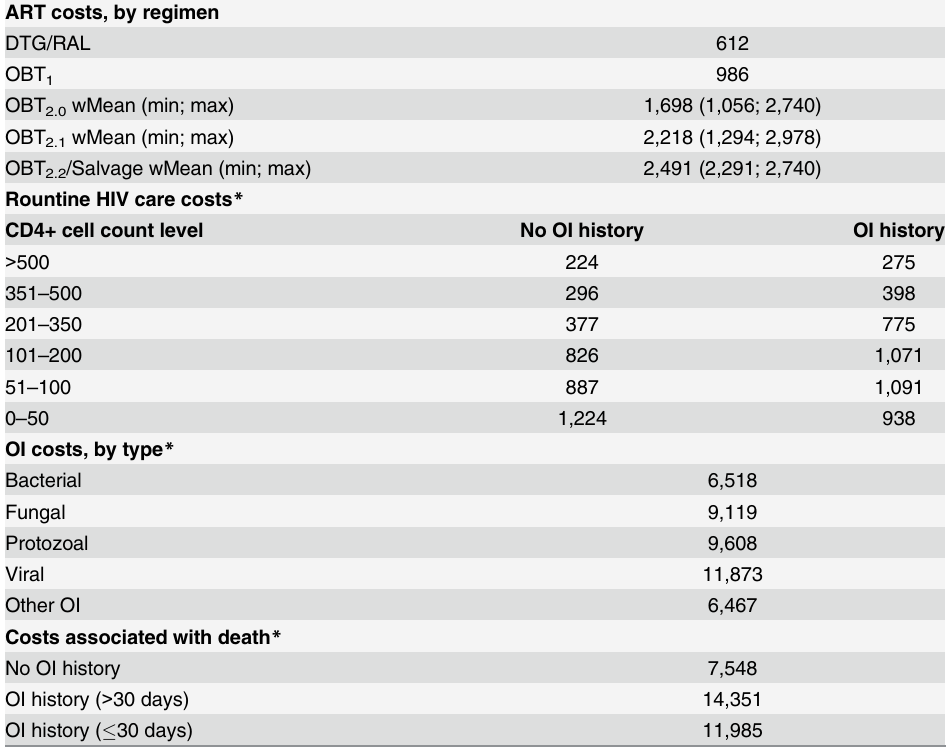
Table 3. Monthly costs ( € 2012 –